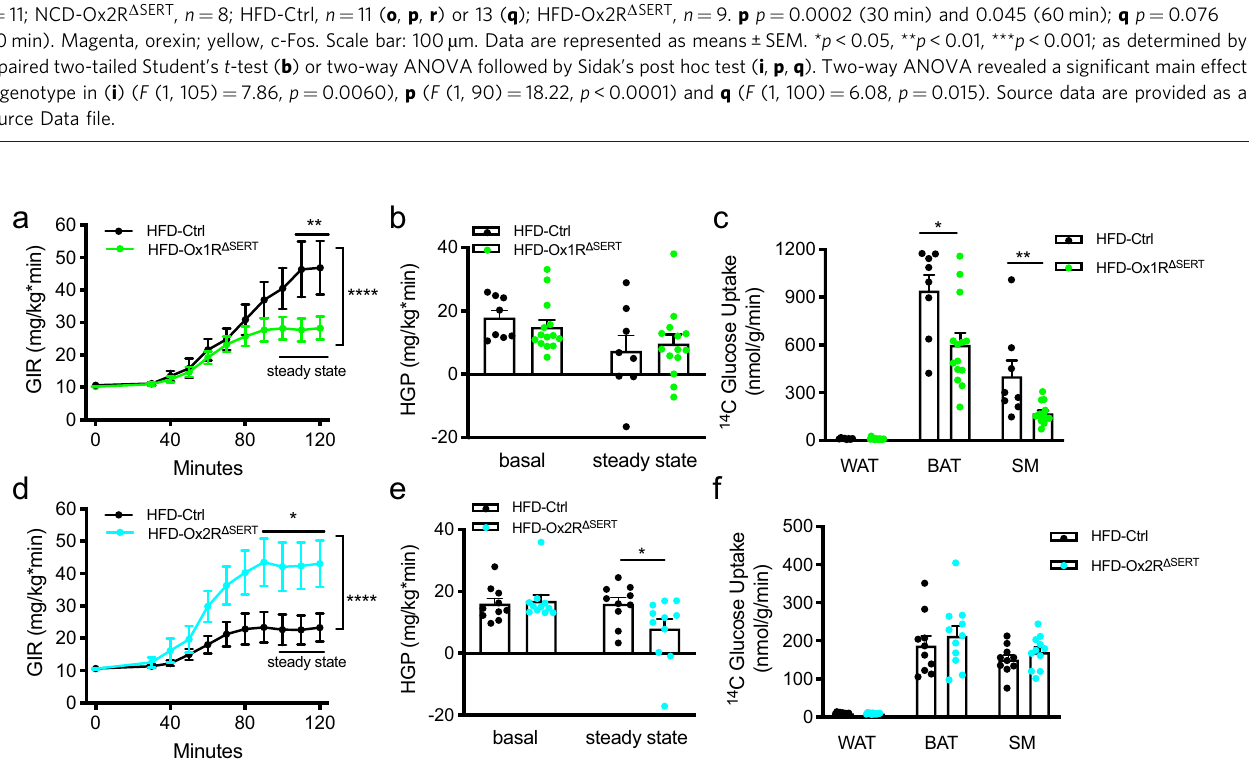
Fig. 5 Insulin sensitivity is impaired in Ox1R Δ SERT mice but improved in Ox2R Δ SERT mice fed a HFD in hyperinsulinemic-euglycemic clamp analysis. a Clamp glucose infusion rates (GIR), b hepatic glucose production (HGP) in the basal state and during the steady state of clamp analysis, and c tissue- speci fi c insulin-stimulated [1- 14 C]-Deoxy-D-glucose uptake in white adipose tissue (WAT), brown adipose tissue (BAT), and skeletal muscle (SM) under steady-state conditions of control (Ctrl) and Ox1R Δ SERT mice. HFD-Ctrl, n = 8; HFD-Ox1R Δ SERT , n = 14. a p = 0.0025 (110 min) and 0.0028 (120 min); c p = 0.011 (BAT) and 0.0070 (SM). d Clamp GIR, e HGP in the basal state and during the steady state of clamp analysis, and f tissue-speci fi c insulin- stimulated [1- 14 C]-Deoxy-D-glucose uptake in WAT, BAT, and SM under steady-state conditions of control (Ctrl) and Ox2R Δ SERT mice. HFD-Ctrl, n = 10; HFD-Ox2R Δ SERT , n = 11. d p = 0.034 (90min), 0.047 (100min), 0.041 (110 min) and 0.042 (120 min); e p = 0.048. Data are represented as means± SEM. * p < 0.05, ** p < 0.01; as determined by two-way ANOVA followed by Sidak ’ s post hoc test ( a , d ) or unpaired two-tailed Student ’ s t -test ( c , e ). Two-way ANOVA revealed a signi fi cant main effect of genotype in ( a ) ( F (1, 220) = 18.30, p < 0.0001) and ( d ) ( F (1, 209) = 35.39, p < 0.0001). Source data are provided as a Source Data fi results indicate that glucose metabolism is improved in obese mice upon selective inactivation of Ox2R in serotonergic neurons.